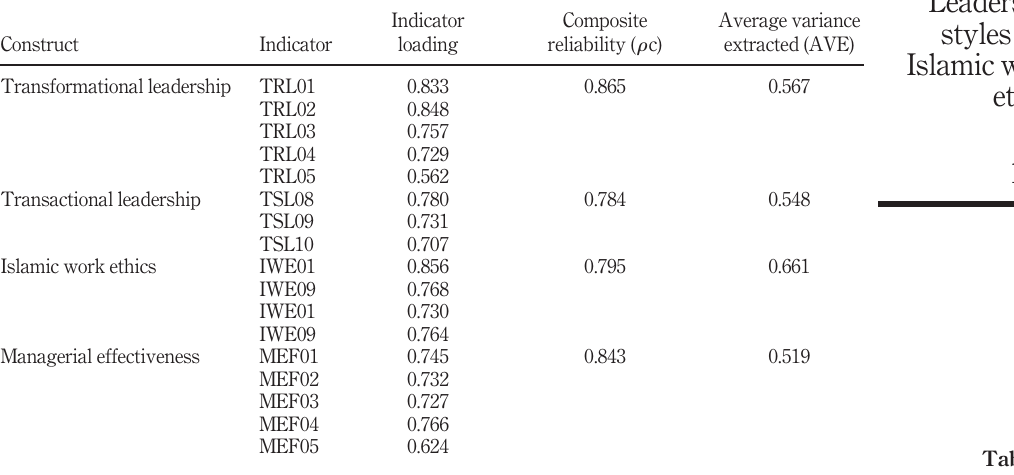
Table 1. Measurement model evaluation